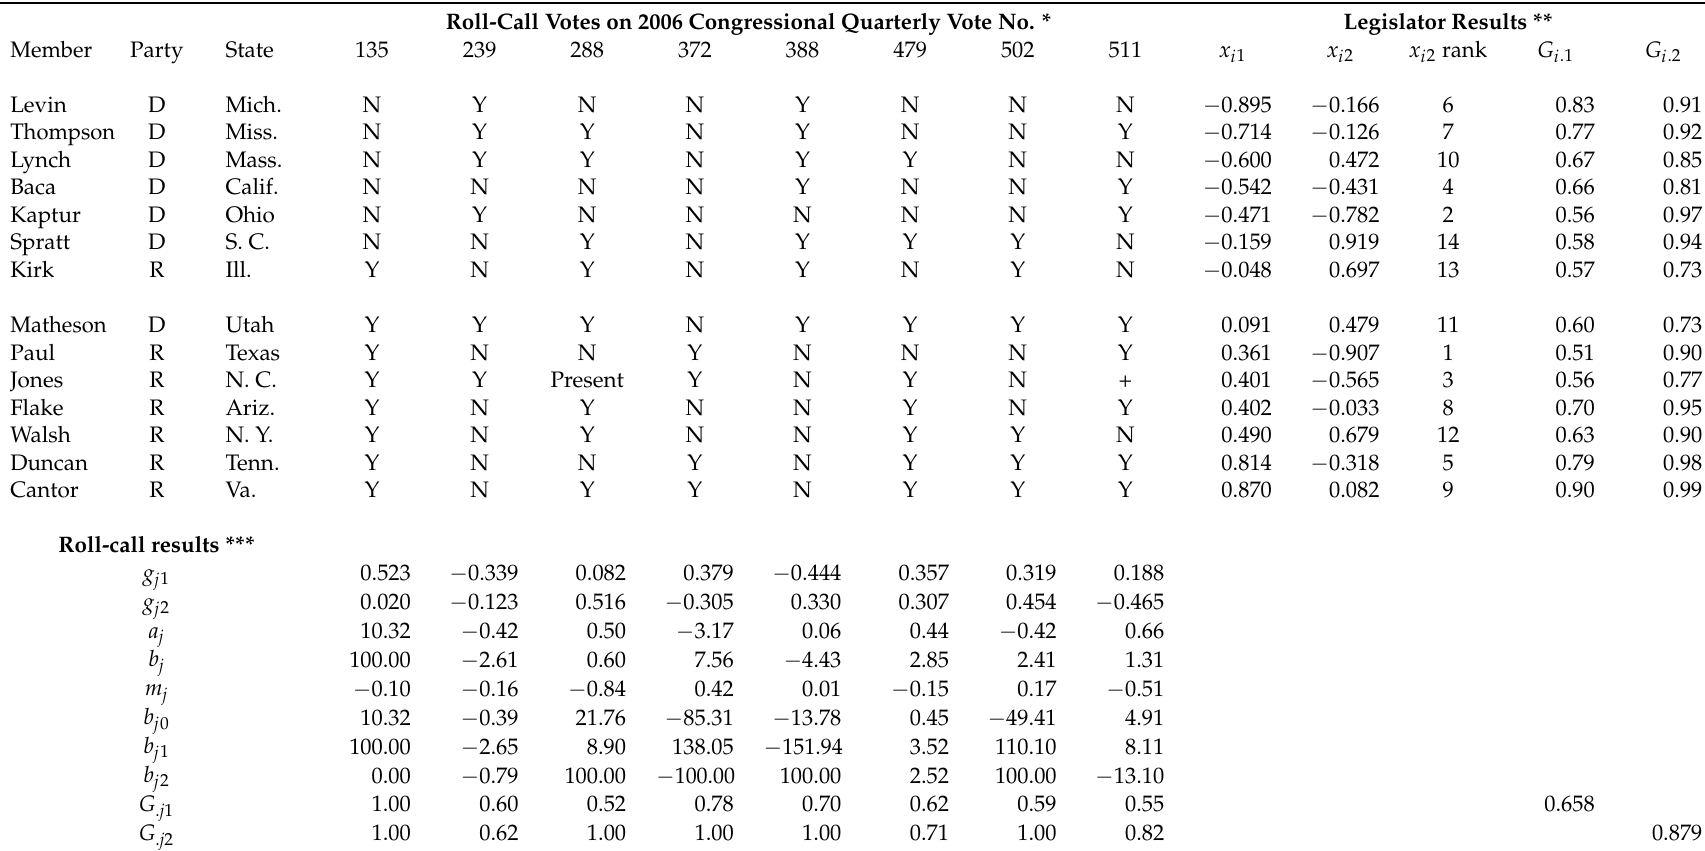
Table 1. Data and results for Example 1 (14 US House members, eight of the 12 CQ key votes for